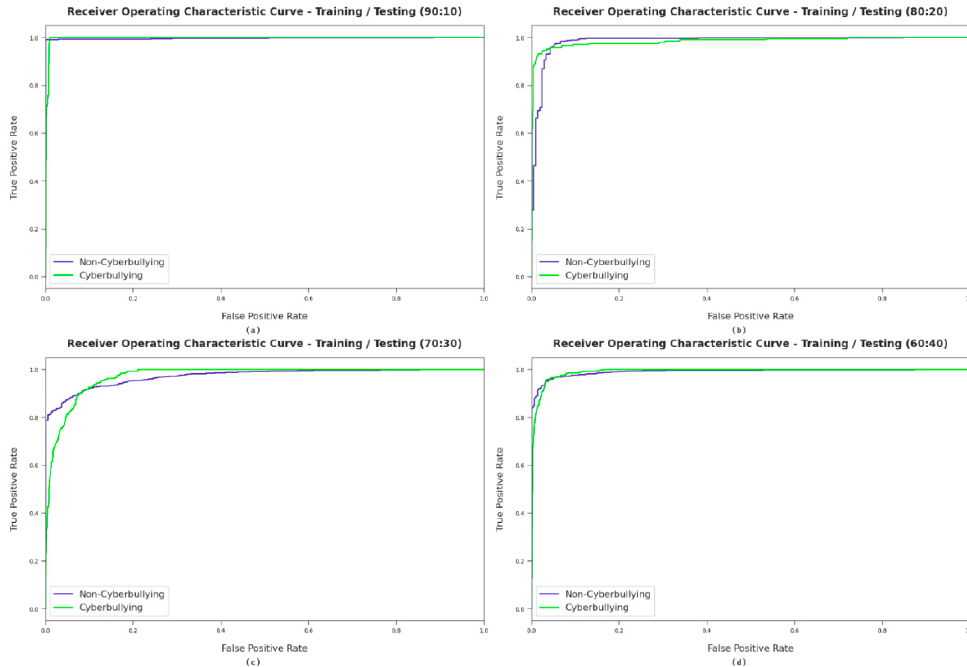
Figure 5. The ROC analysis of the proposed model with different training/testing dataset sizes.